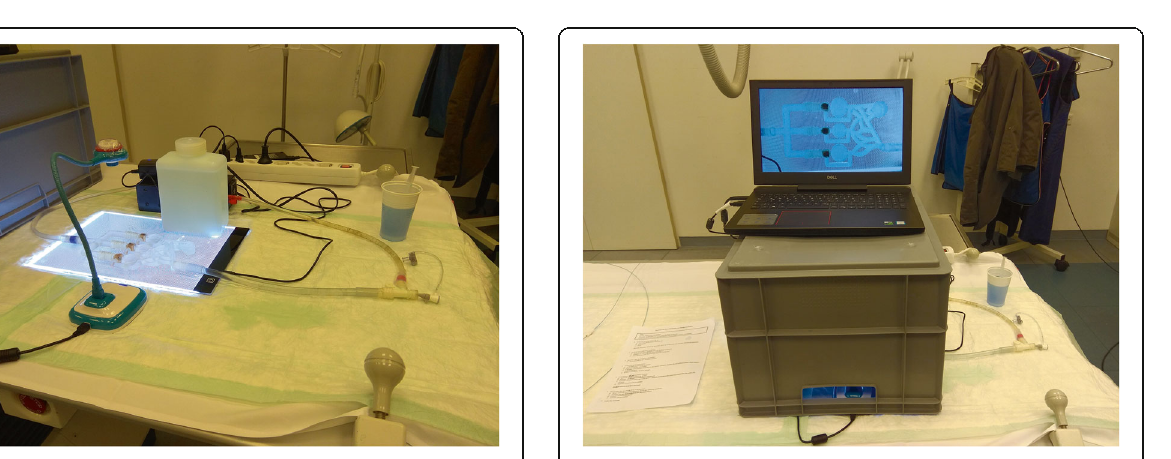
Fig. 2 Training environment consisting of the 3d-printed model with connected pump, underlying LED panel and portable camera